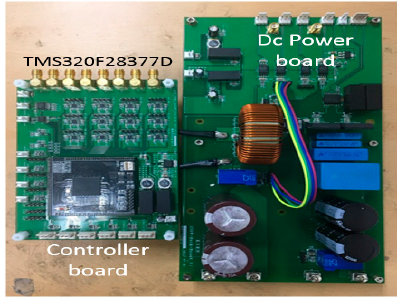
Figure 20. Experimental setup with boost converter.